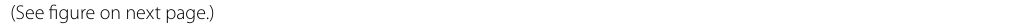
figure on next Fig. 4 The BR combination induces mutant KRAS -selective stress hyperactivation and cell death. CRC cells with either WT or mutant KRAS were treated with vehicle (Un), or the Bortezomib (B) and Everolimus (R) combination (BR, 5 nM and 10 µM, or as specified). a Dose response of 8 cell lines at 48 h was assessed by MTS assay. Dotted (blue) or solid lines represented cells with MUT or wtKRAS. b Apoptosis at 48 h was analyzed by nuclear fragmentation assay. c Attached cells at 48 h were visualized by crystal violet staining. d Apoptosis at 48 h was analyzed by nuclear fragmentation assay. e qRT-PCR analysis of indicated genes at 24 h visualized by heatmap. The expression was normalized to untreated isogenic mutant KRAS cells (1). f Western blotting of indicated proteins at 0, 4 and 24 h. g DEGs (FC 2, p < 0.005) in BR-treated WT vs. mut KRAS HCT 116 cells at 24 h ≥ visualized by volcano plot. Selected down-regulated genes (green) in WT KRAS cells are shown. h GSEA of differential genes in the indicate pair (C2 dataset). The indicated gene set is shown with NES and corresponding p -value. i Cells were transfected with either empty vector (VC) or HA-MYC plasmid for 24 h, replated for 24 h, and treated with BR. Western blotting of indicated proteins at 24 h, and j apoptosis at 48 h analyzed by nuclear fragmentation assay. a, b, d, j, values are mean s.d. ( n 3). * p < 0.05, ** p < 0.01, *** p < 0.001, **** p < 0.0001 (Student’s t -test, two tailed). WT vs. mut + = KRAS BR group or cell line, or VC vs .